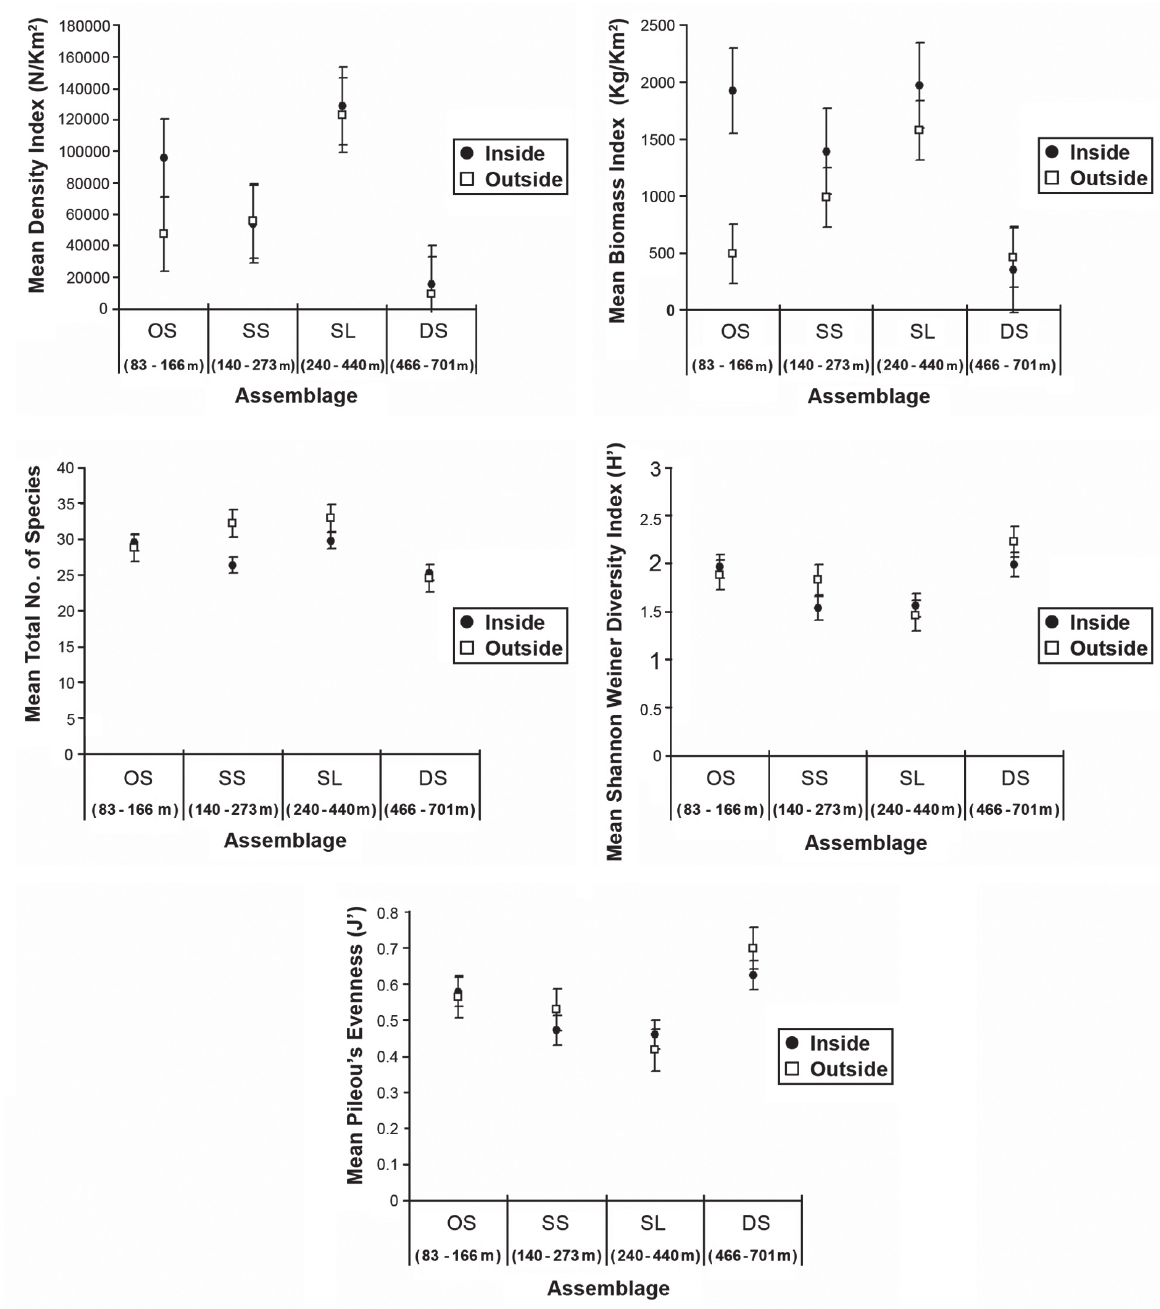
Fig 3. – Mean (± standard error) values of mean density index in N/km 2 , mean Biomass index in kg/km 2 , mean number of species, mean Shannon-Weiner diversity ( H’ ) and mean Pielou`s evenness ( J’ ) for each of the four main groups of stations. OS, Outer Shelf; SS, Shelf Break; SL, Shallow Slope; DS, Deep